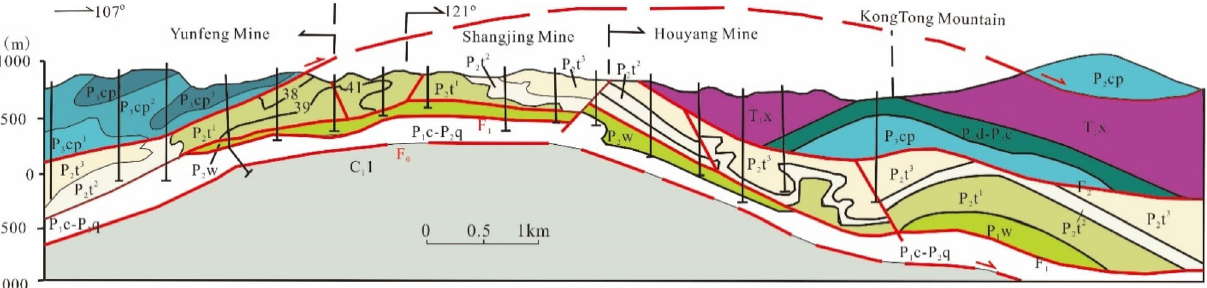
Fig. 9 Geological profile of the Datian Mine in Shangjing County, Fujian, SE China (section position see Fig.